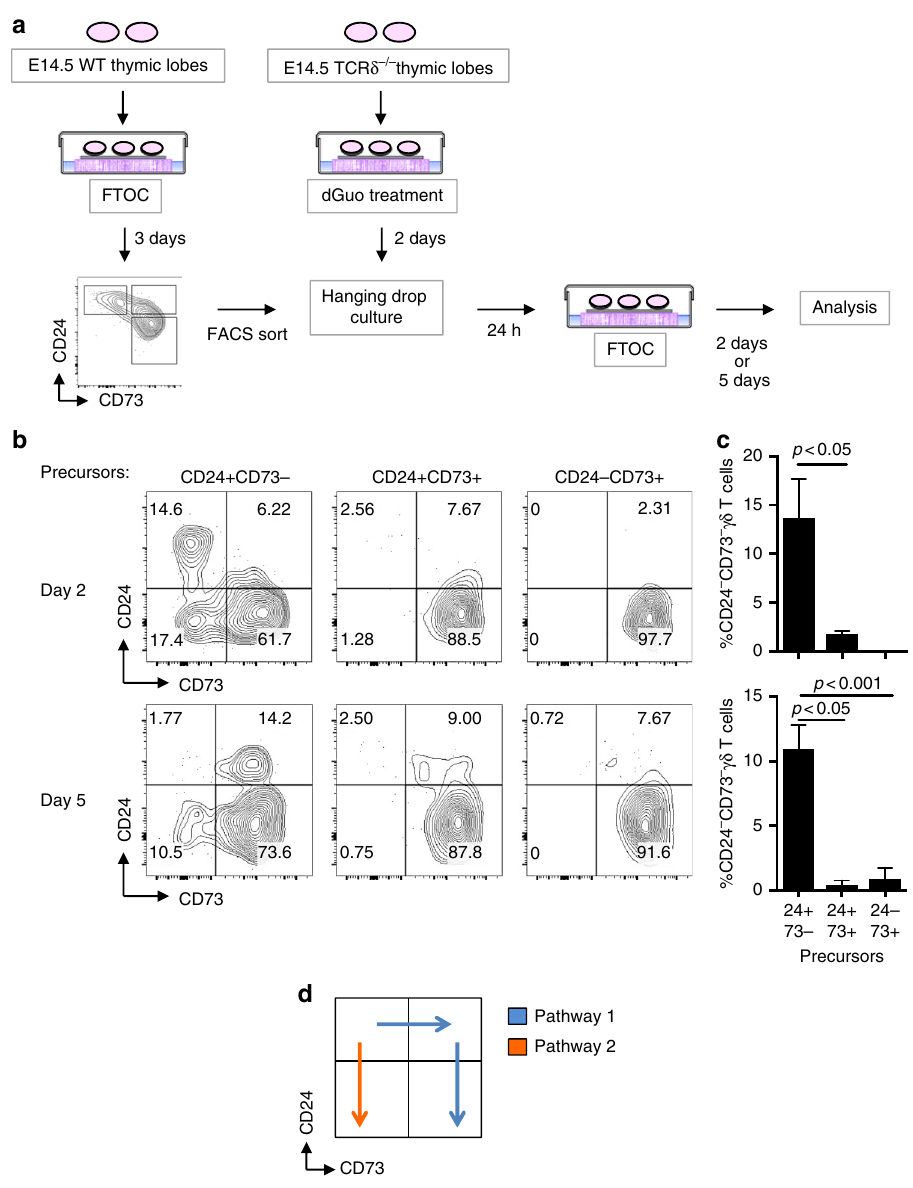
Fig. 2 Developmental pathway of CD24 − CD73 − γδ T17 cells. a Schematic of the precursor-product experiment designed to determine the differentiation pathway of CD24 − CD73 − γδ T17 cells. Thymic lobes from E14.5 CD1 embryos were collected and cultured in FTOC for 3 days. Next, CD24 + CD73 − , CD24 + CD73 + , and CD24 − CD73 + γδ T cells (all CD3 + TCR γδ + ) were sorted by FACS and incubated with E14.5 TCR δ -de fi cient thymic lobes overnight in hanging drop culture. The TCR δ -de fi cient lobes were prepared in advance by treatment with 2 ′ -deoxyguanosine monohydrate (dGuo) for 2 days followed by resting for 1 – 2 days in media. The colonized lobes were transferred to FTOC and analyzed 2 and 5 days later. b Representative FACS plots of the developmental outcomes of the CD24 + CD73 − , CD24 + CD73 + , or CD24 − CD73 + γδ T-cell precursors in FTOC for 2 or 5 days. Numbers in FACS plots indicate frequency within each gate. All plots are gated on CD3 + TCR γδ + cells. c Frequencies of CD24 − CD73 − γδ T cells obtained from CD24 + CD73 − , CD24 + CD73 + , or CD24 − CD73 + γδ T cells precursors at d2 and d5. d Schematic of the routes through development taken by γδ T-cell precursors on Pathway 1 (blue) vs. Pathway 2 (orange). Data are representative of at least three independent samples. Center values indicate mean, error bars denote s.e.m. p- values were determined by two